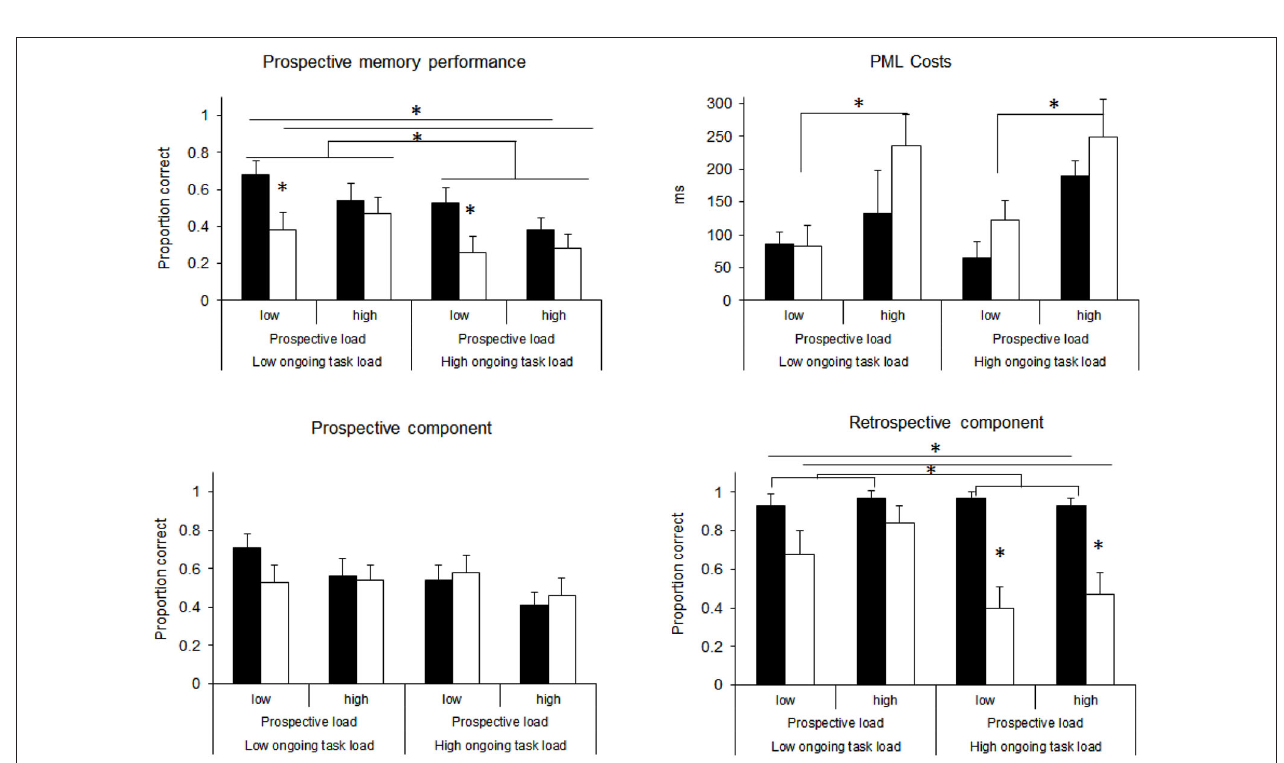
FIGURE 4 | Results of Experiment 2, separately for overall prospective memory performance, PML Costs in the ongoing task, the prospective component (releasing the shift-key), and the retrospective component